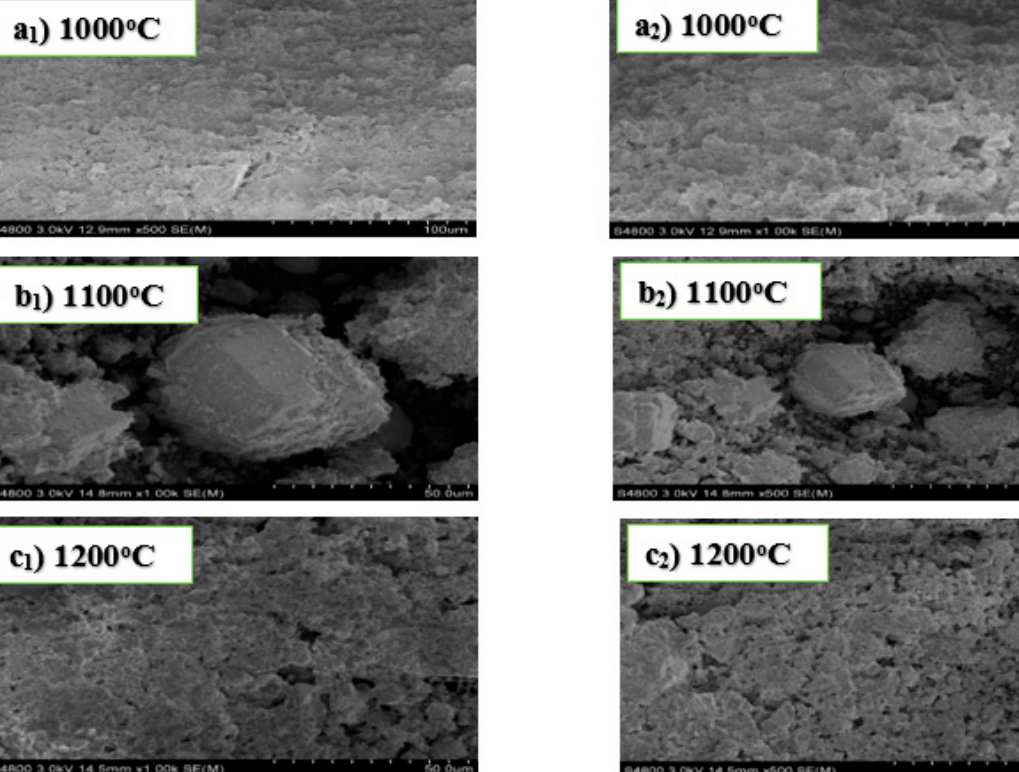
◦ C ( a ◦ C ( b 1 , a 2 ), 1100 1 , b 2 ), and 1200